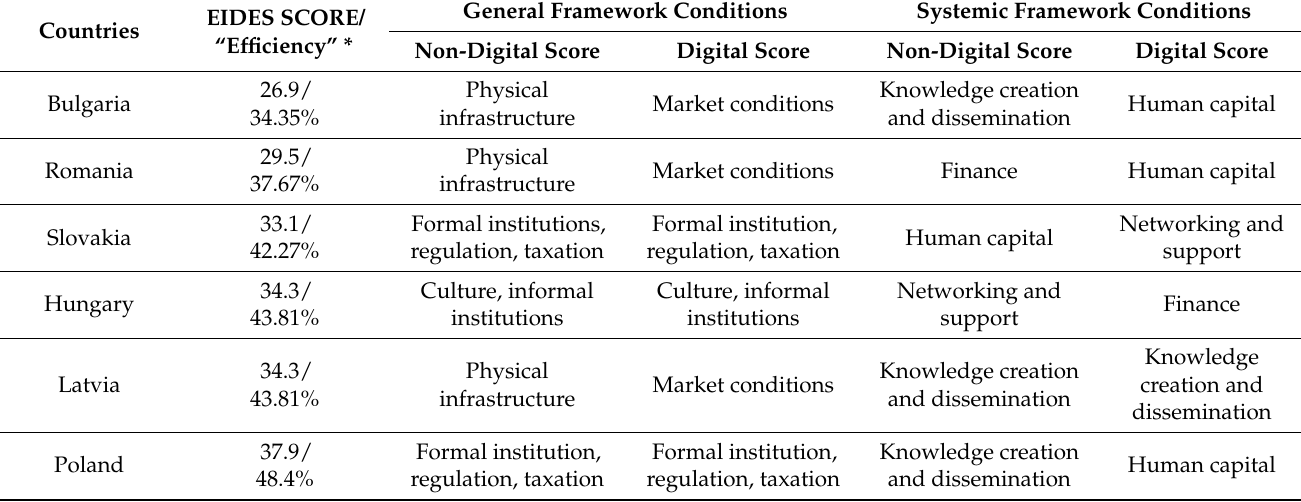
Table 7. The weakest pillars of